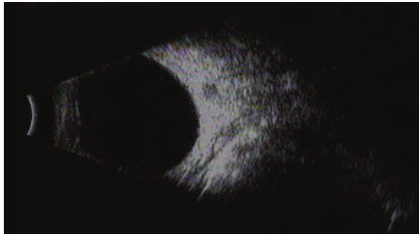
Figure 3: B-scan ultrasonography showed a clear vitreous cavity of a patient after the surgery of silicone oil removal.